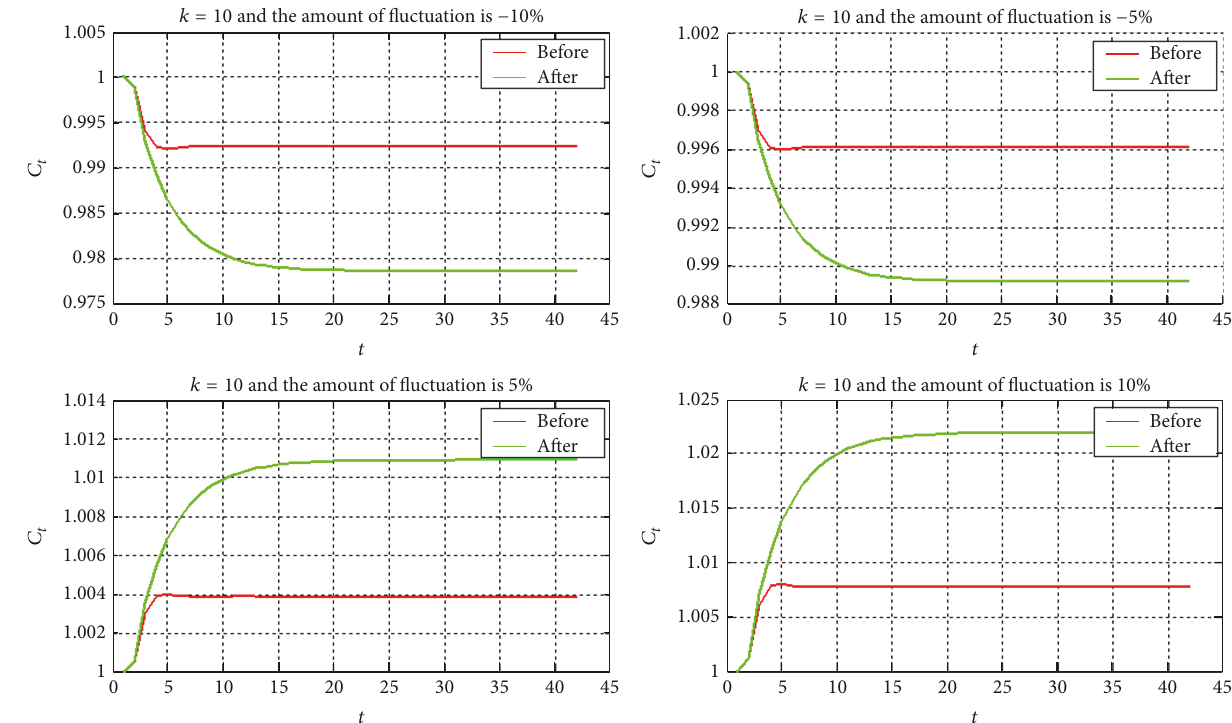
Figure 4: Influence of initial fluctuation on network stability when 𝐾 = 10